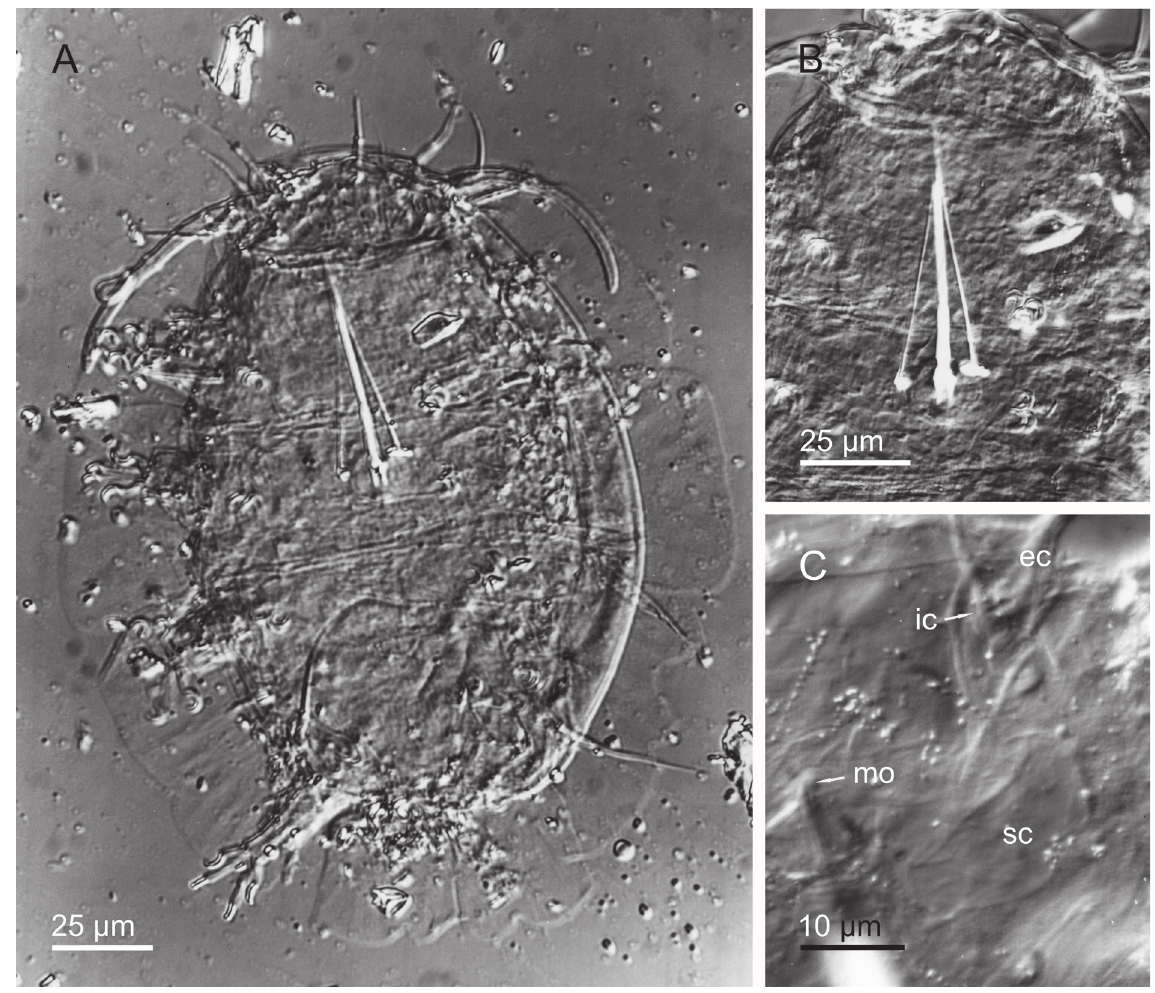
Fig. 9. DIC-micrographs of Higginsarctus shintai gen. et sp. nov., holotype, ♀ (NHMD-293904). A . Overview. B . Bucco-pharyngeal apparatus. C . Close up on the head, ventral view showing the secondary clava, internal and external cirri. Abbreviations: see Material and